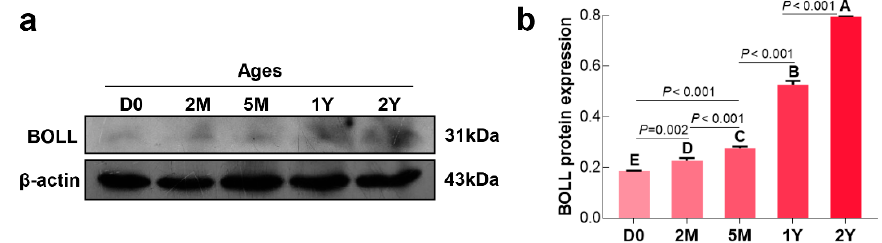
Figure 3. Relative BOLL protein expression in sheep testes at different ages. ( a ) A representative Western blot detection result; ( b ) The integrated density values (IDVs) of BOLL protein from β -actin was used as an internal reference protein. The experiment was biologically repeated three times. The bars represent the mean values ± SD of three replicate samples obtained from three sheep per group. Different capital letters denote an extremely significant difference between groups ( p < 0.01): D0: 0 days old; 2M: 2 months old; 5M: 5 months old; 1Y: 1 year old; 2Y: 2 years old.